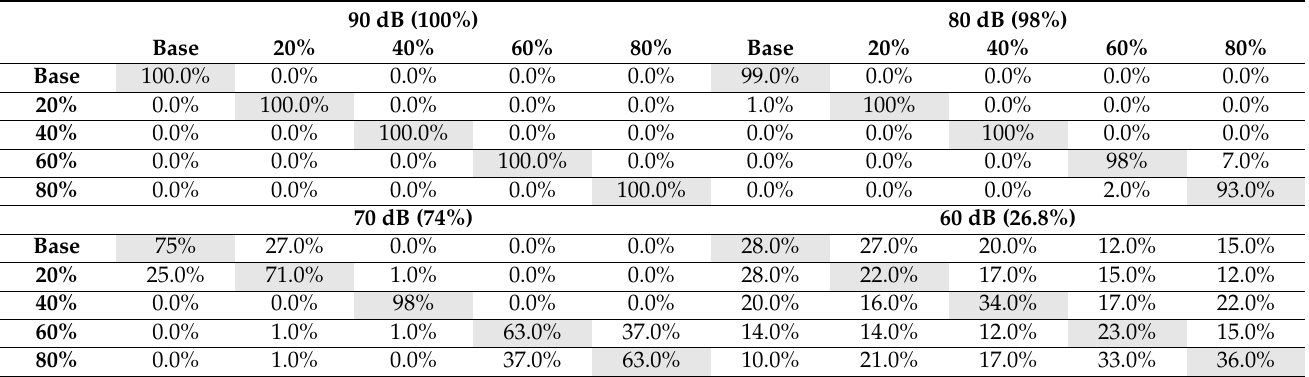
Table 3. Confusion matrices at various noise